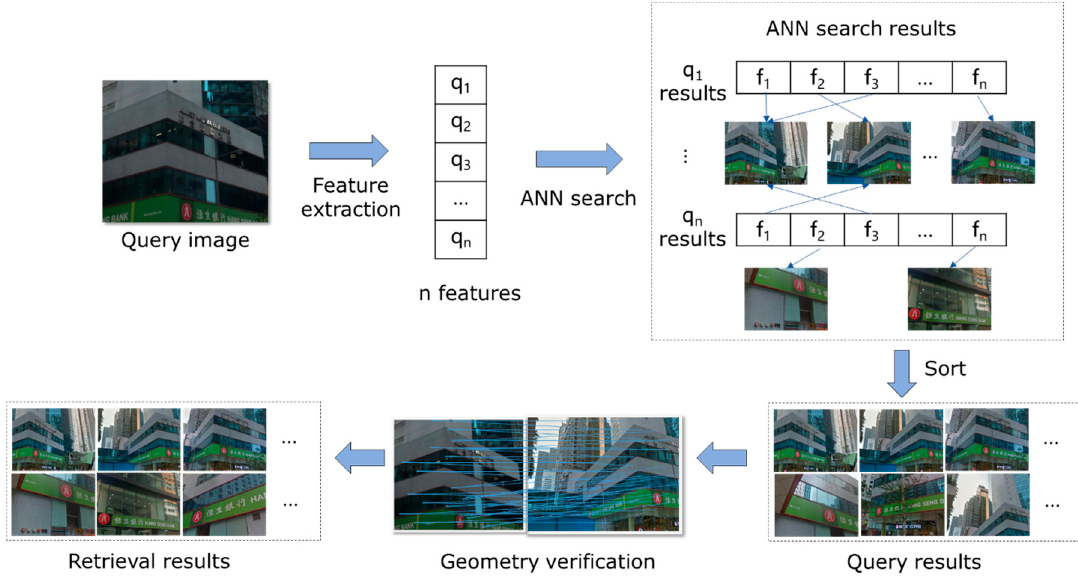
Figure 6. The approximate nearest neighbor (ANN) search workflow.